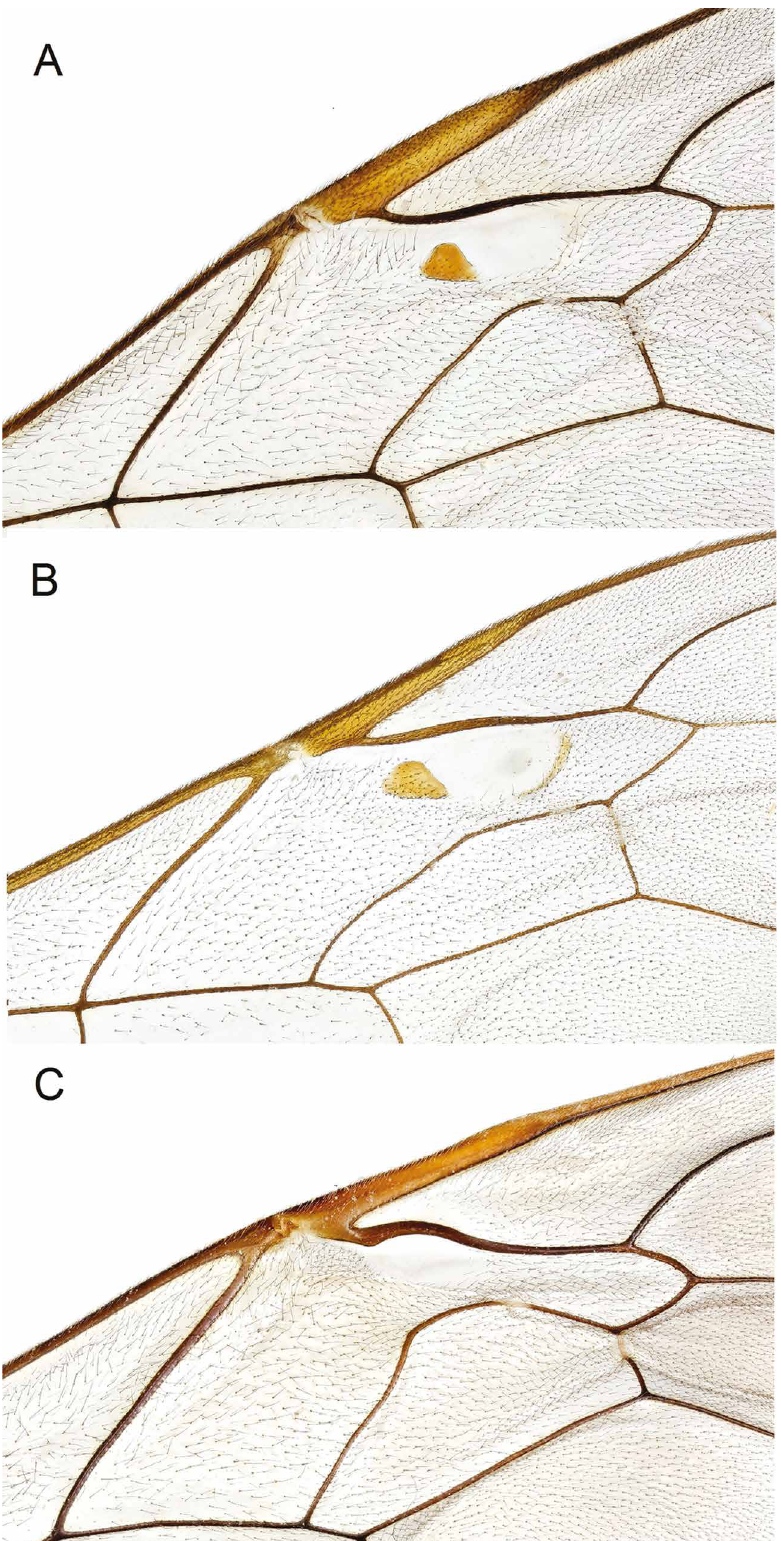
Fig. 13. Central part of fore wing. A . Enicospilus repentinus (Holmgren, 1860), ♀. B . Enicospilus merdarius (Gravenhorst, 1829), ♀. C . Enicospilus inflexus (Ratzeburg, 1844),